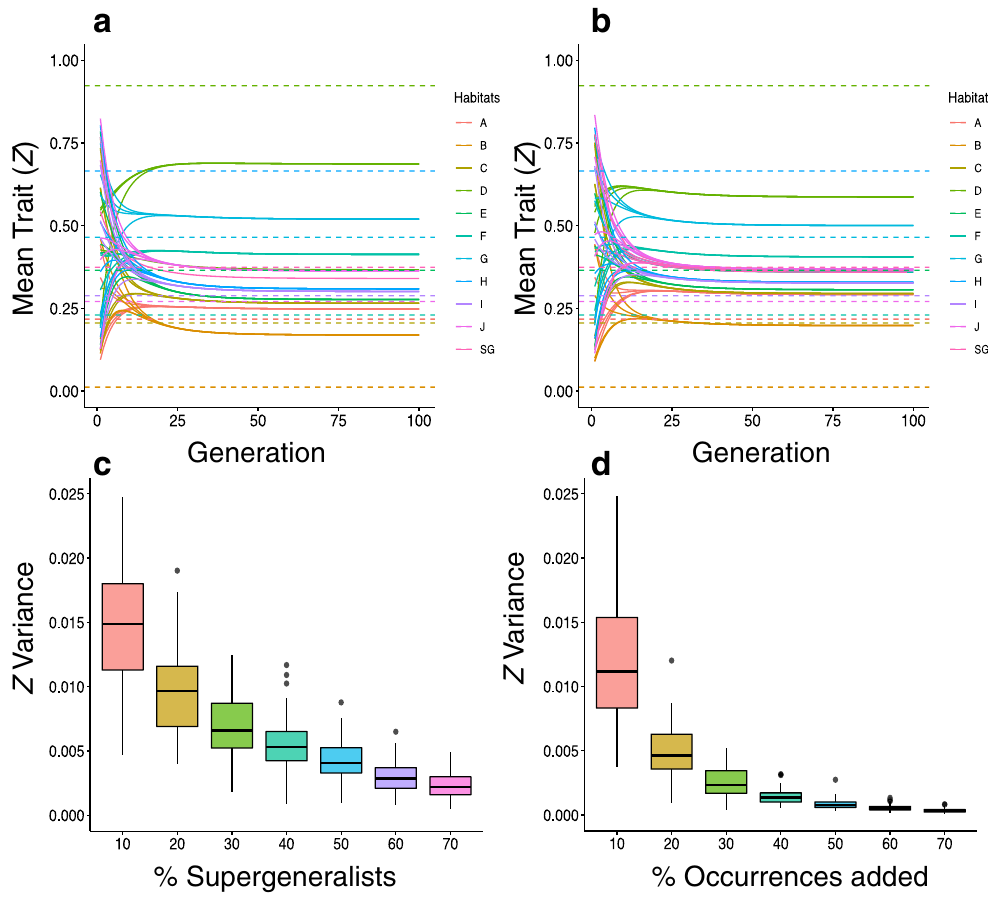
Figure 5. Including supergeneralist, which is a species that occur in all habitats, or occurrences, starting from the perfectly modular scenario . In ( a ) and ( b ), each habitat is represented by one color, dashed line is the habitat optima, each continuous line is one species and their color is the same as the habitat optima where they occur. (a) The change of trait value in 100 generations when there is only one supergeneralist (SG) in a community. (b) The change of trait value in 100 generations when 10% of the species in a community are supergeneralist (SG). (c) Variability of trait values after 100 generations in 100 simulations with different percentages of supergeneralist in a community. (d) Variability of trait value after 100 generations in 100 simulations with different percentages of occurrences in a